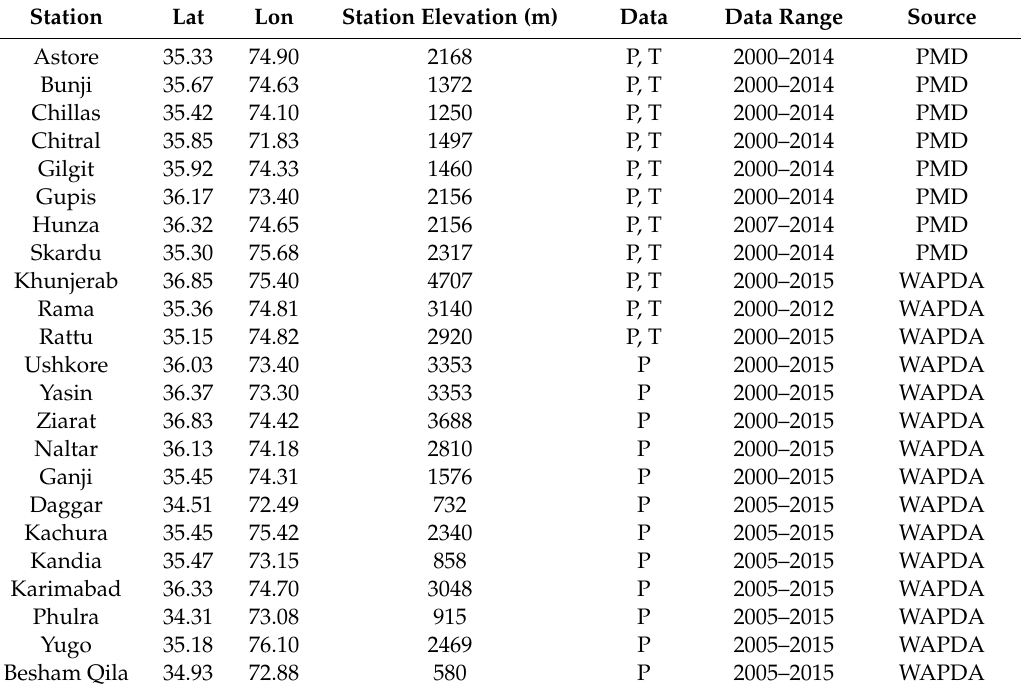
Table 2. PMD stations, their locations, elevation, and the respective domain. PMD, Pakistan Meteorological Department; WAPDA, Water and Power Development Authority. P and T represent precipitation and average temperature,